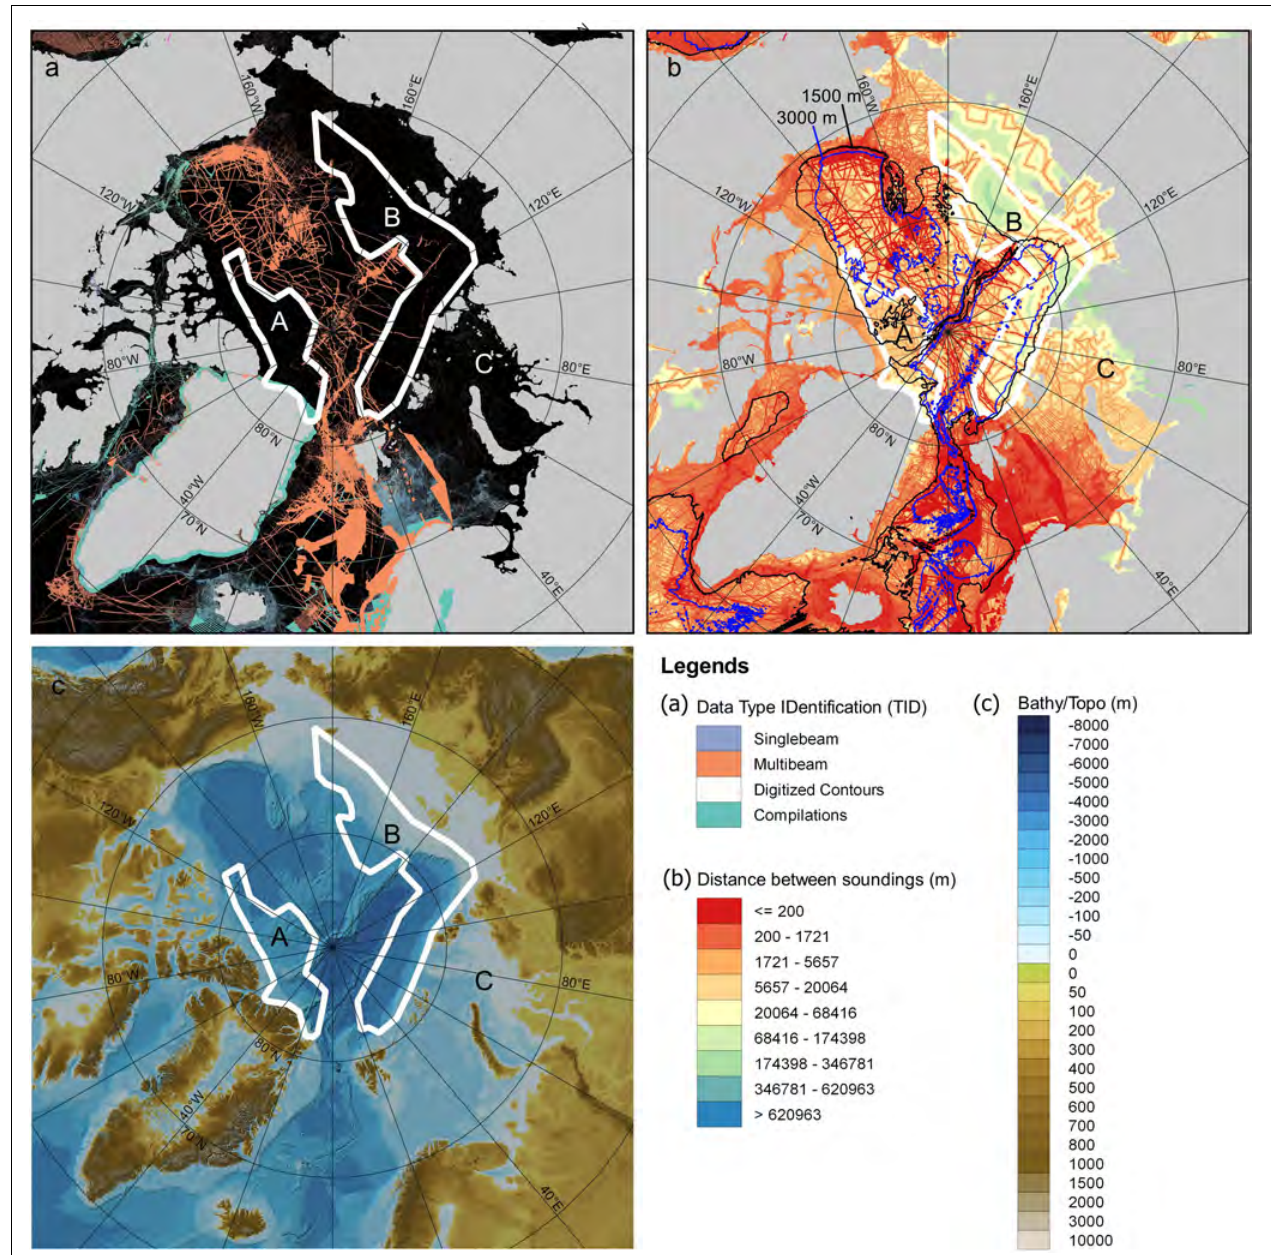
FIGURE 5 | Analyses of the IBCAO 4.1 underlying depth database and identification of three areas (A–C) in the central Arctic Ocean where the database is particularly poor. (a) Map showing the distribution of different types of data (see legend). (b) Map showing horizontal distances between depth data (multibeam, single beam and spot soundings from charts are included). The 1,500 and 3,000 m depth contours are shown as they indicate the required data densities (distance between data points) considering the Seabed 2030 target gridding resolutions; 0–1,500 m: 100 m × 100 m grid cell size; 1,500–3,000 m: 200 m × 200 m grid cell size; 3,000–5,750 m: 400 m × 400 m grid cell size (exceed deepest location in the Arctic Ocean) 5750–11,000: 1,100 m × 400 m grid cell size (c) . The areas A–C overlaid on the IBCAO 4.1